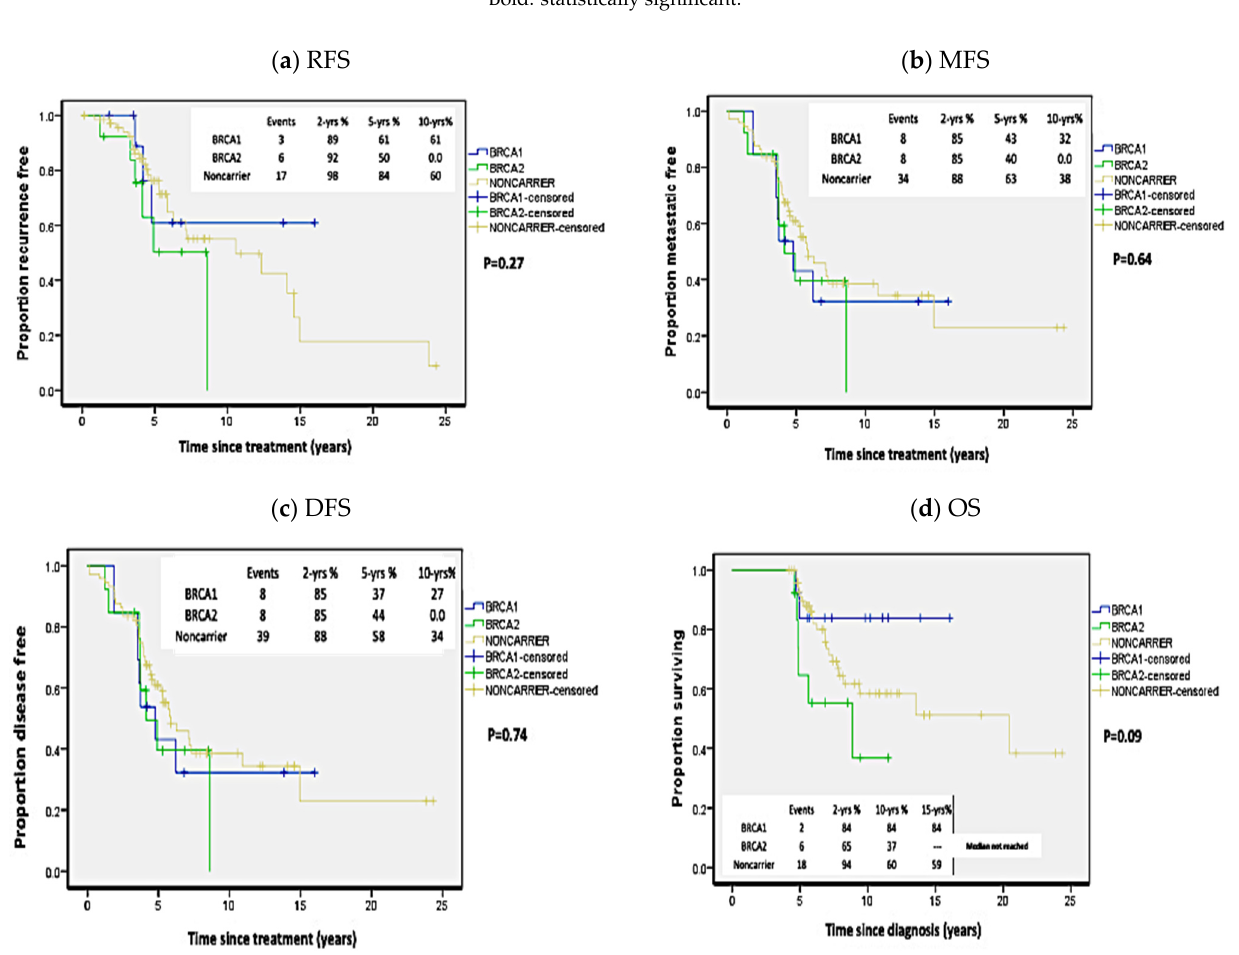
Figure 3. Kaplan Meier plots of survival analysis in carriers of BRCA1 and BRCA2 mutations independently and non-carriers. ( a ) Recurrence-free survival (RFS), ( b ) Metastasis-free survival (MFS), ( c ) Disease-free survival (DFS), ( d ) Overall survival (OS). p -values calculated by log-rank test (considering whole follow-up period).